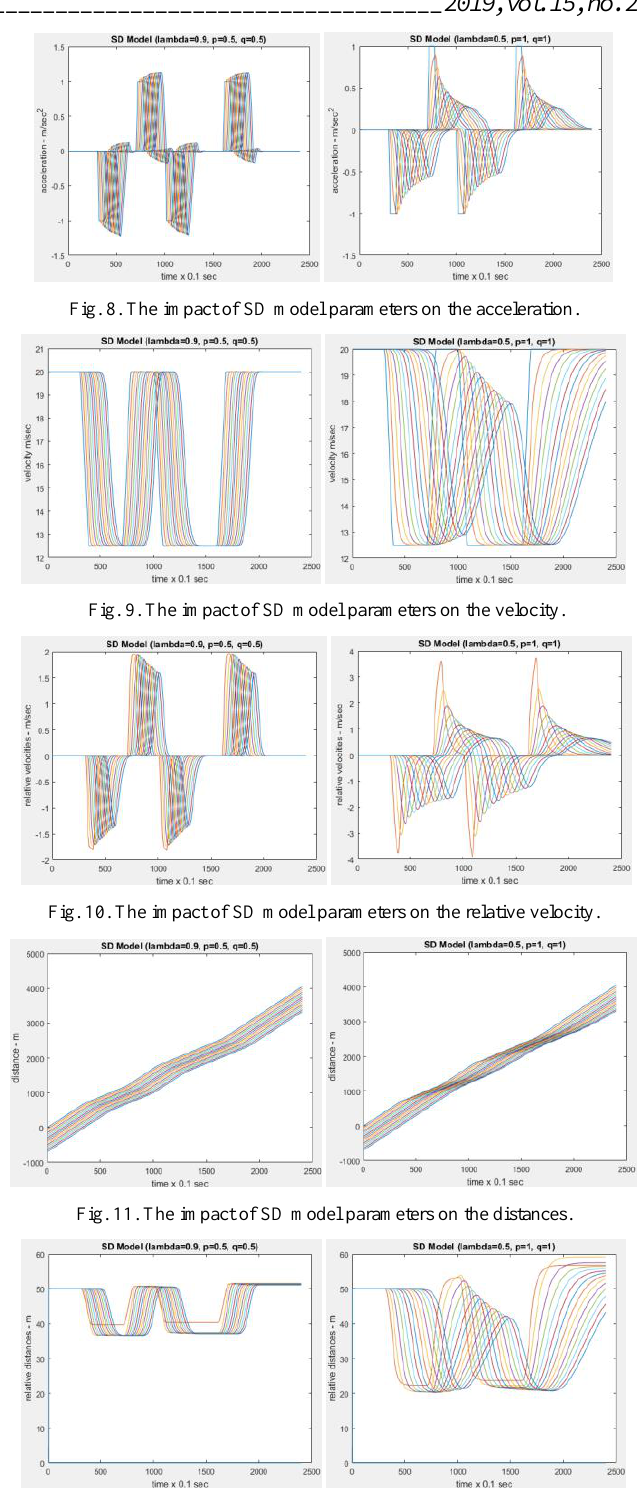
Fig. 12. The impact of SD model parameters on relative